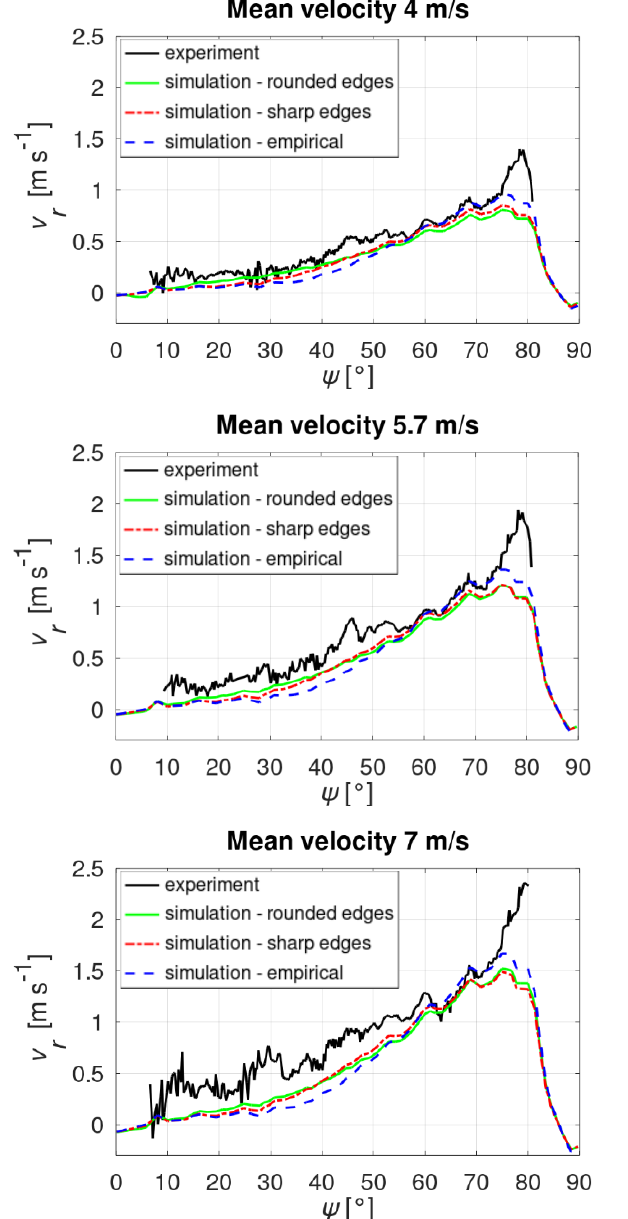
Fig. Radial velocity 15 mm below the plate .